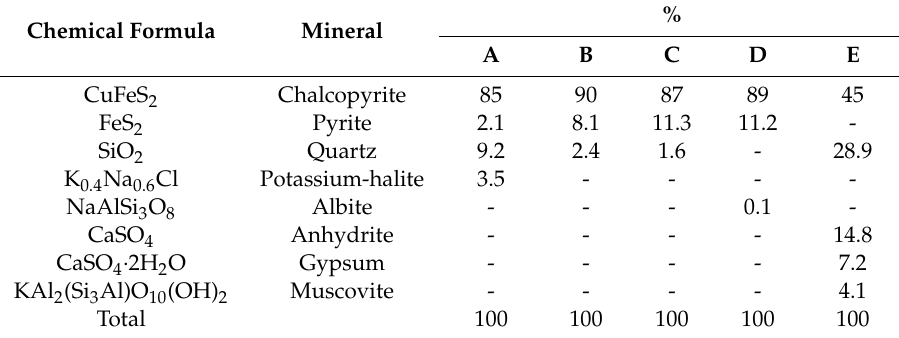
Table 2. Mineralogy of samples used (particle size of − 150 + 75 µ m).